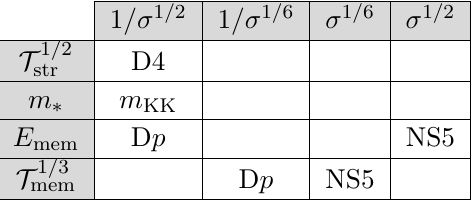
Table 5 . Elementary flow ˆ s i → ∞